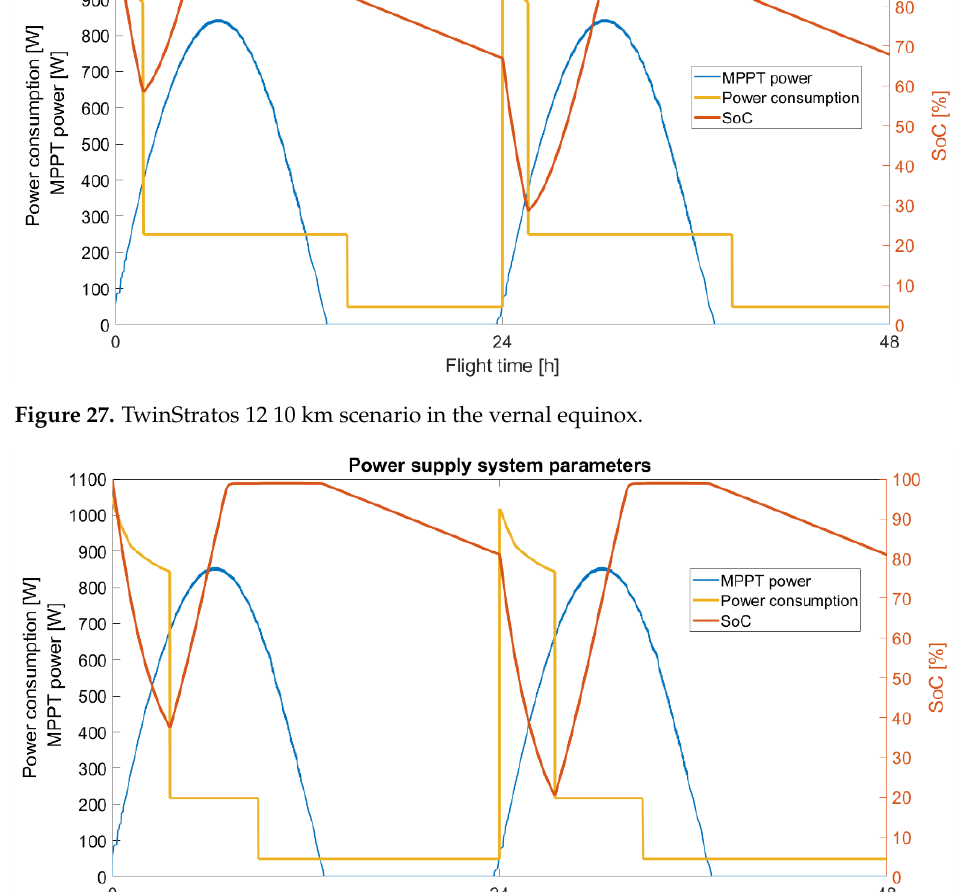
Figure 29. TwinStratos 12 20 km scenario in the vernal equinox. During the summer solstice, TS12 was able to fly for over 24 h (Figure 30). The low- est SoC was at the beginning of the flight, up to the moment when the power from the PV was higher than the current power consumption, which occurred about 4 h and 30 min after take-off. The lowest value of SoC was equal to 22.5%. On the second day, the battery began to lower the SoC when the power from the PV was lower than the power con- sumption.